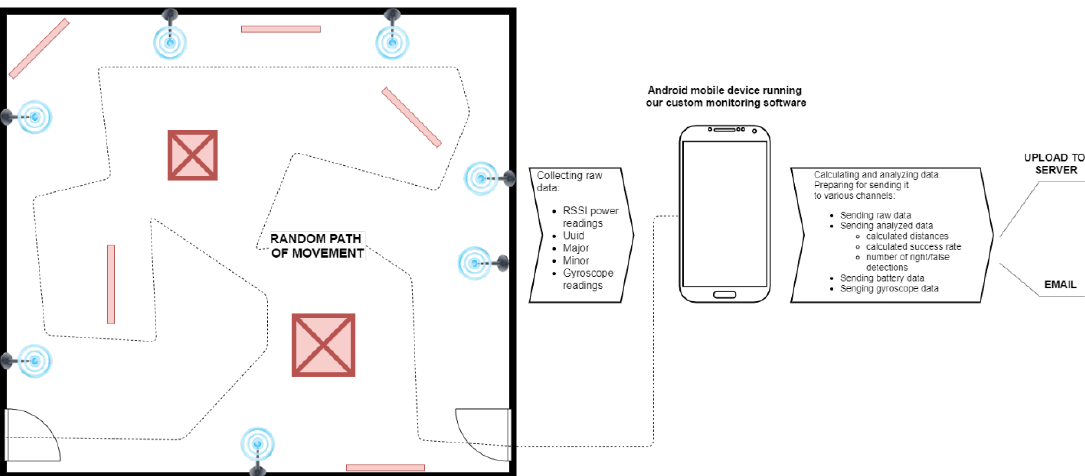
Figure 1. The flow of experiment measures in a controlled room.